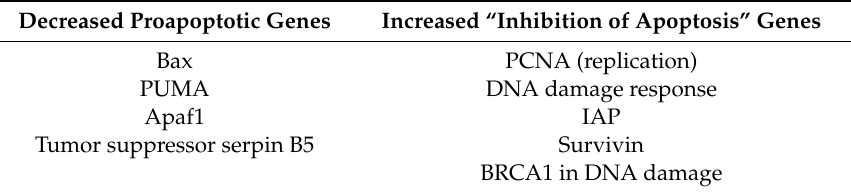
Table 4. Several common changes in the resistant cell lines in the expression of genes involved in induction and inhibition of